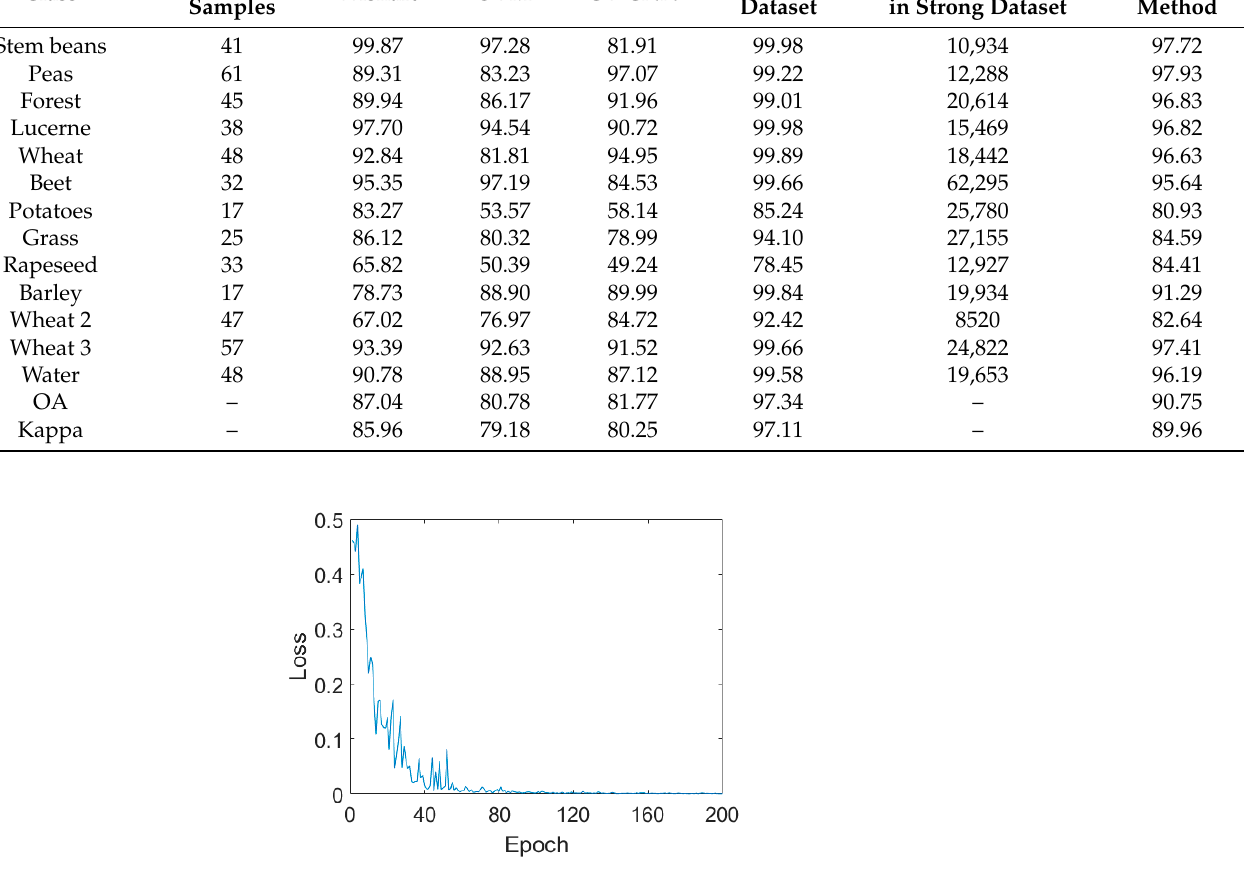
Figure 4. Loss curves on the Flevoland dataset. Table 2. Classification precision for the Flevoland dataset (%).